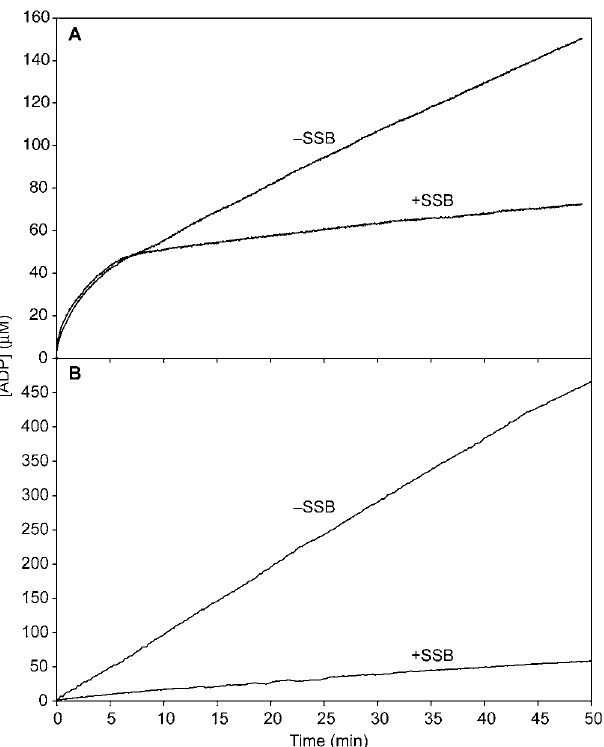
Figure 6. The Effect of SSB Protein in Suppressing Rebinding of RecA to the Single-Strand Tails (A) Normal RecA filament disassembly protocol. The RecA filaments were formed on the tailed DNA at pH 6.62. The pH was then shifted to 8.0 to allow disassembly to commence. Disassembly curves are shown in the presence and absence of SSB. Reactions contained (after the pH shift) 2 l M RecA protein, 2 l M DNA, and (where indicated) 0.05 l M SSB. (B) Direct binding of RecA protein to the tailed DNA at pH 8.0. Reactions contained 6 l M RecA protein, 6 l M DNA, and (where indicated) 0.15 l M SSB. When included, SSB was added prior to the RecA protein.